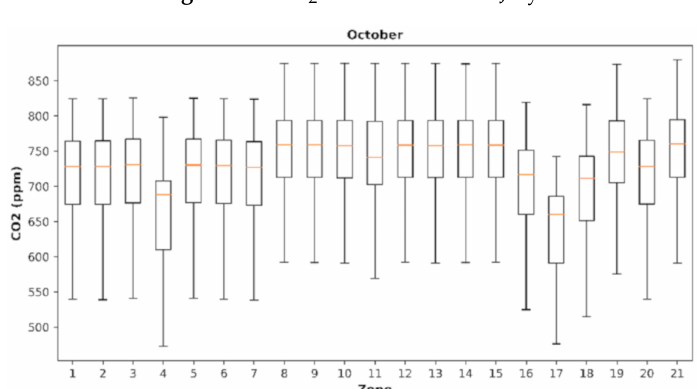
Figure A8. CO 2 concentrations in July.